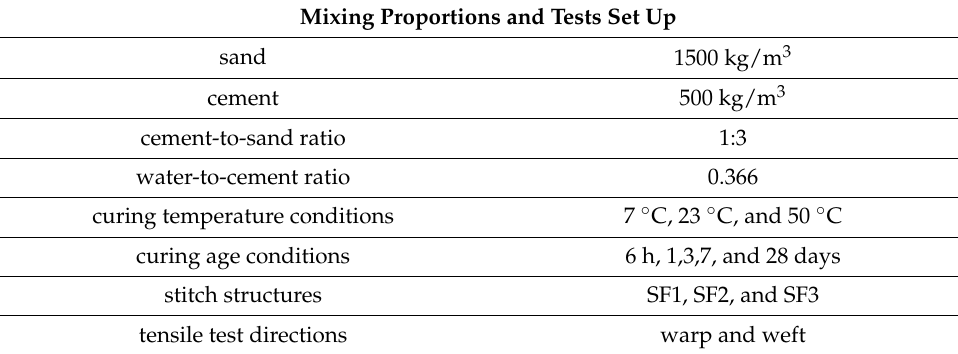
Table 3. Mixing proportions and tests set up